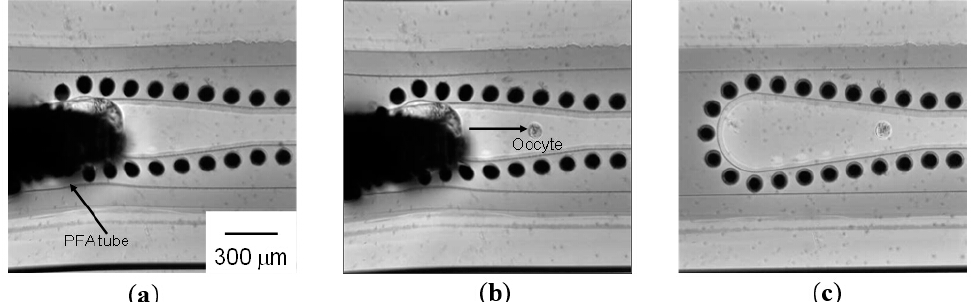
Figure 8. Demonstration of oocyte introduction: ( a ) Before introduction; ( b ) after introduction; ( c ) after removal of the PFA tube.